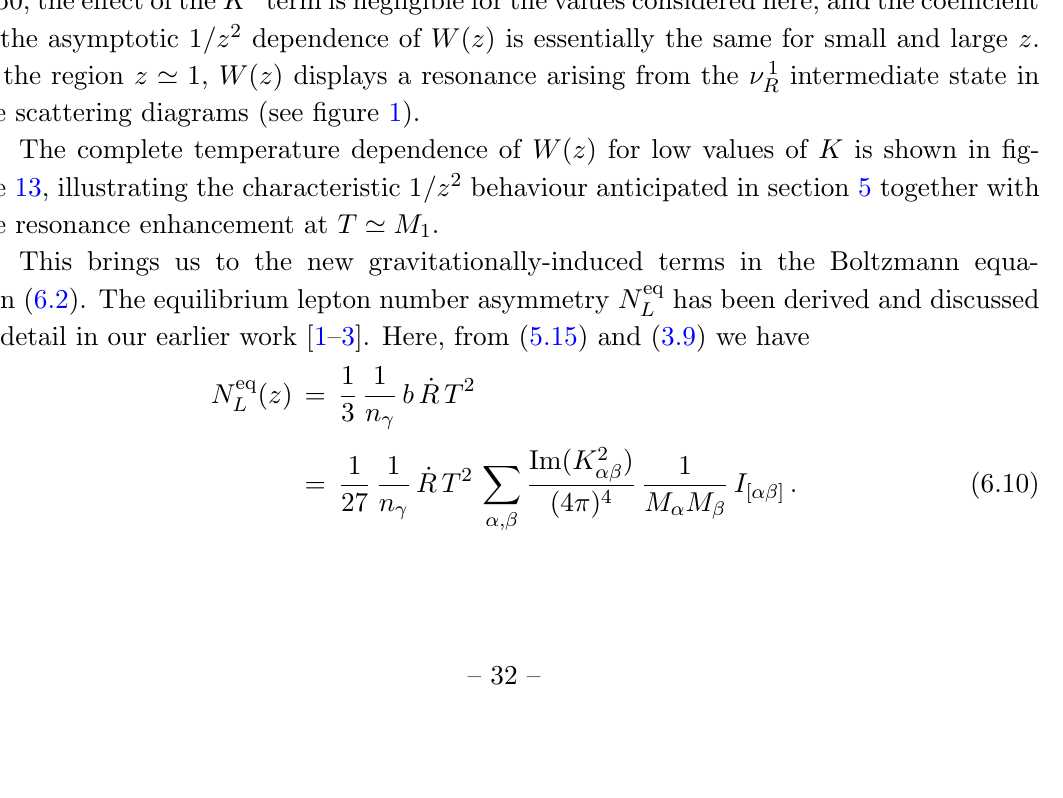
, consistent with the constraints 1